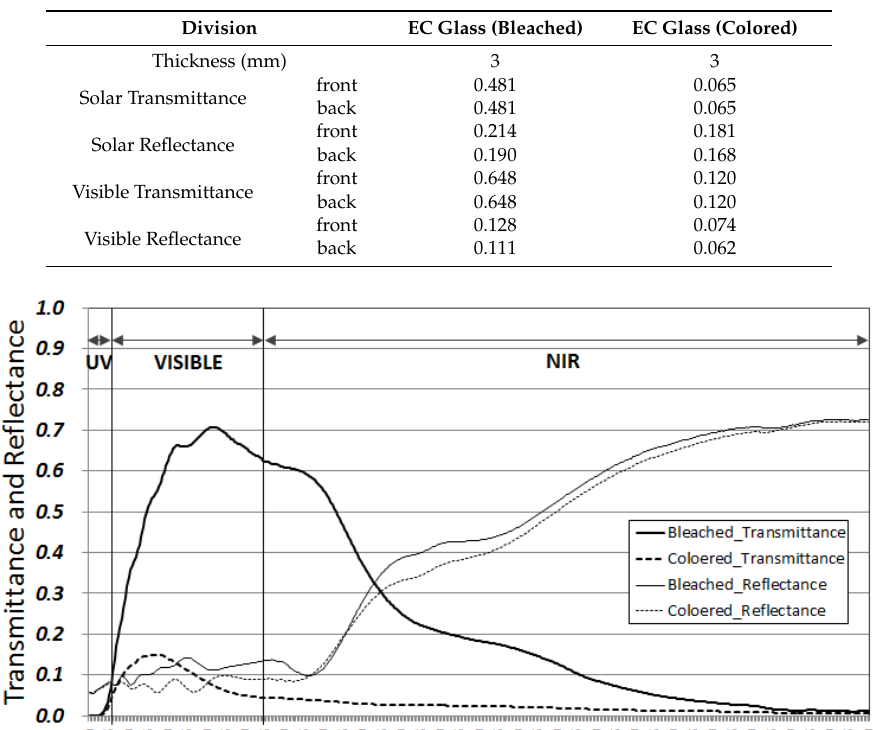
Table 1. The average spectral data of electrochromic (EC) glass.